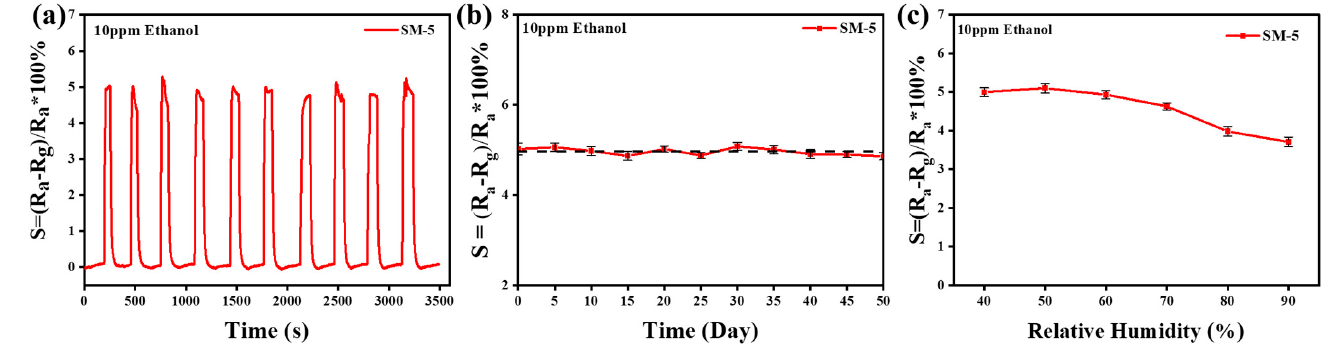
Figure 8. Overall, 10 ppm ethanol for ( a ) the short-term stability test of SM-5 sensor. ( b ) The long-term stability test of SM-5 sensor. ( c ) The relative humidity of 40% to 90% test of SM-5 sensor.